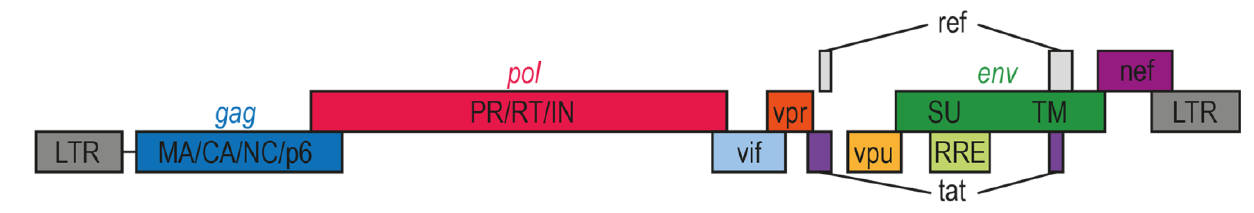
Figure 3: HIV-1 genome. A schematic representation of the HIV-1 gene products encoded by the HIV-1 genomic